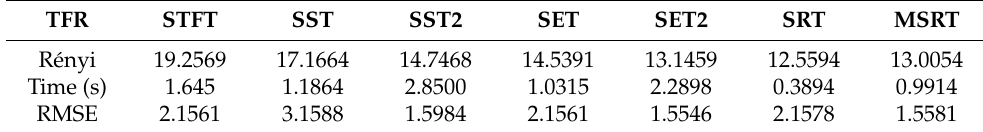
Table 3. Comparison with different time–frequency analysis methods.